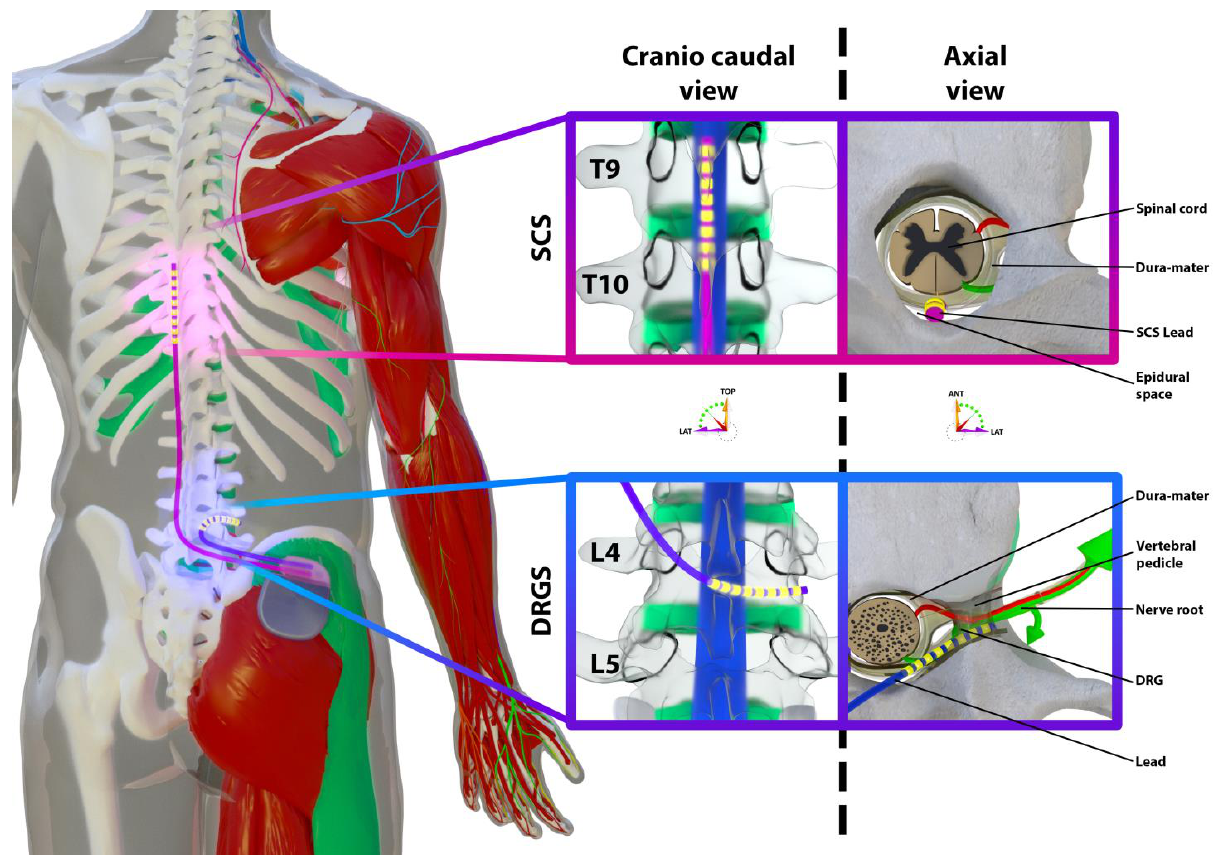
Figure 2. An artistic view illustrating SCS and DRGS